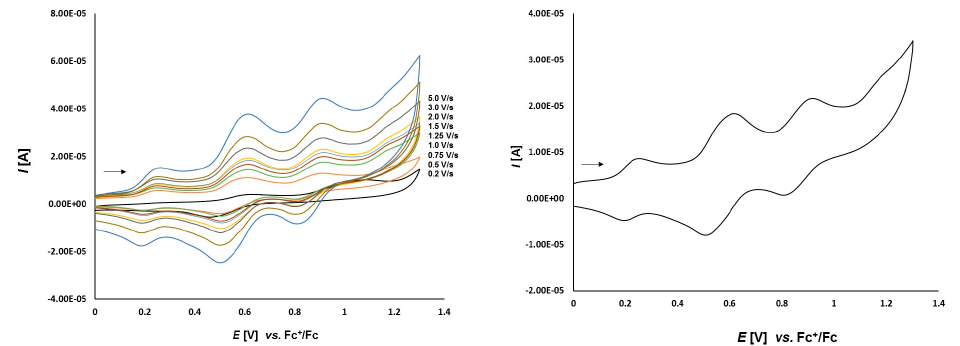
Figure 8. Cyclic voltammetry of complex 3a (1.0 mmol / L) in CH 2 Cl 2 -[ n Bu 4 N][BF 4 ] (0.1 m / L) solutions at various scan rates ( left ) and at v = 1.50 V / s ( right ). The potentials E are given in V and referenced to the Fc + / Fc couple. The arrows indicate the scan direction.